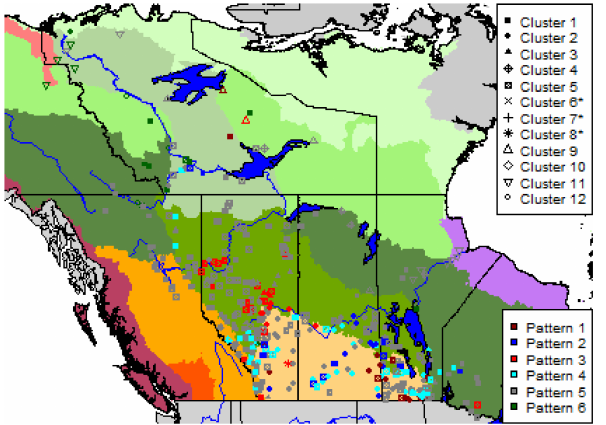
Figure 12. Trend Patterns (colour) and Streamflow Regime Types (cluster no. with symbols) of the 395 stations in the study domain. The ecozone legend is as in Fig. 7.